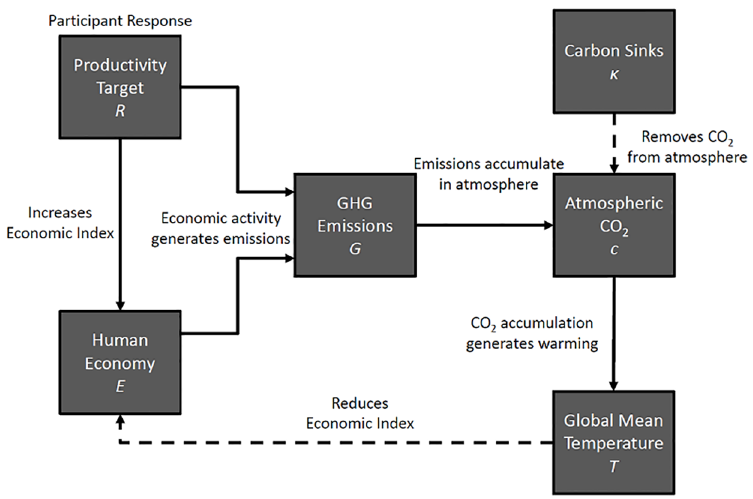
Fig 1. Schematic of the interactive human-climate model. Participants set an economicproductivity target, R , which drives economicgrowth, E , but also generates greenhouse gas emissions, G . Emissions accumulate in the atmosphere, subject to passive removalby natural carbonsinks at rate κ . CO 2 accumulation, c , generates warming, increasing the globalmean temperature, T . Temperature has a negative effect on economicgrowth. Capacityfor economicgrowth is reducedunder